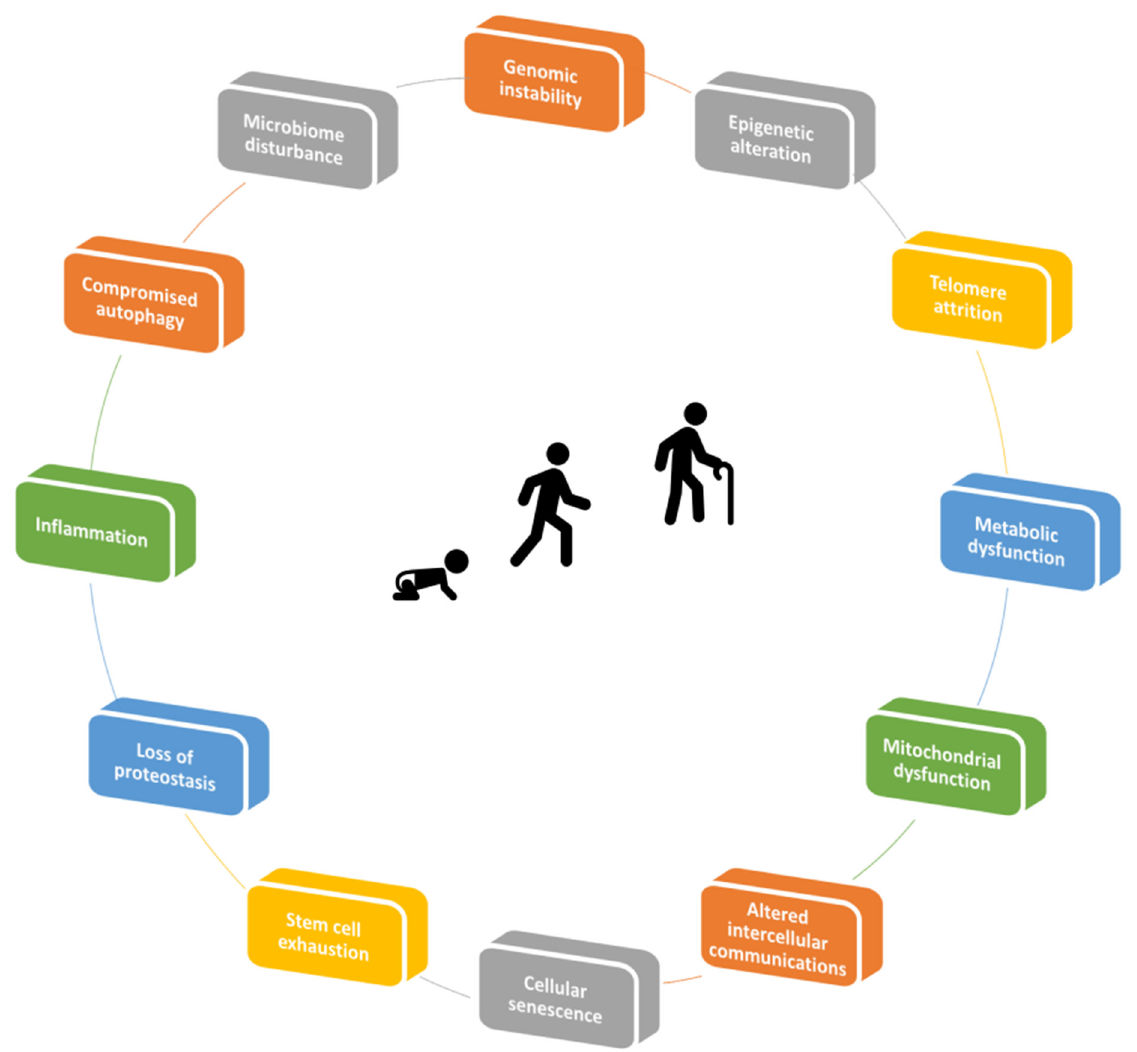
Figure 1. Hallmarks of aging.